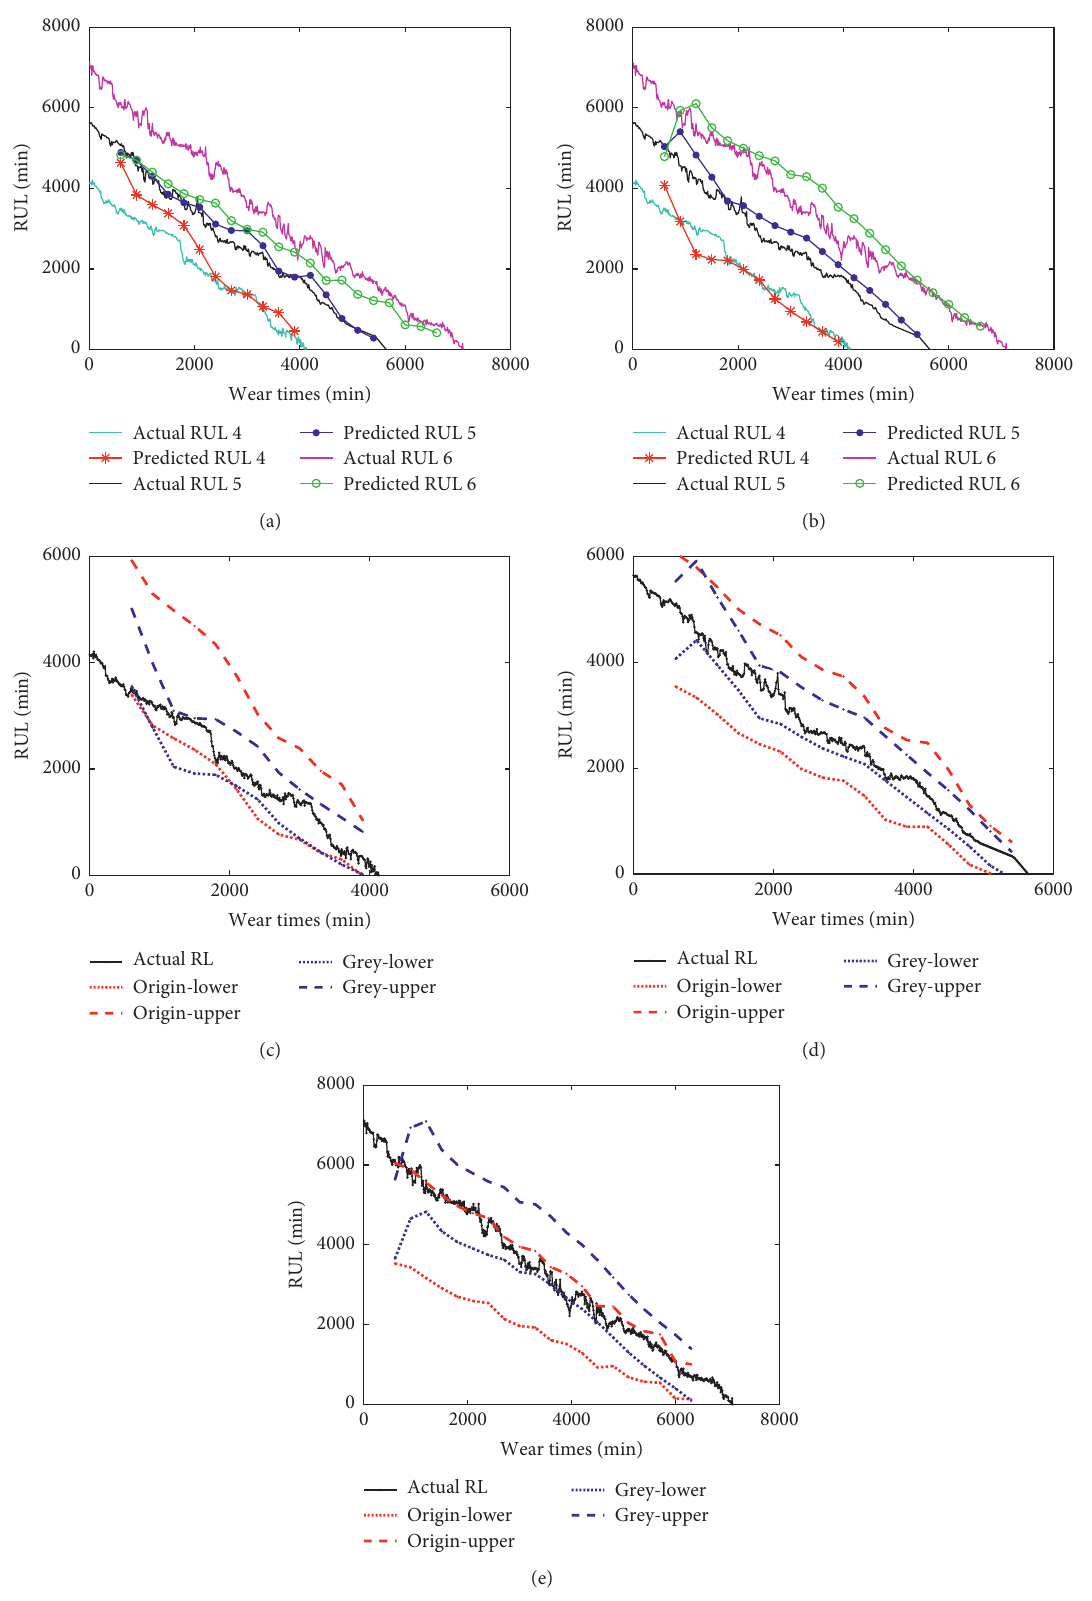
Figure 6: RUL and confidence interval for HSLL based on original wear depth and grey processing data. (a) Origin wear depth. (b) Grey processing data. (c) Confidence interval of samples 4. (d) Confidence interval of samples 5. (e) Confidence interval of samples